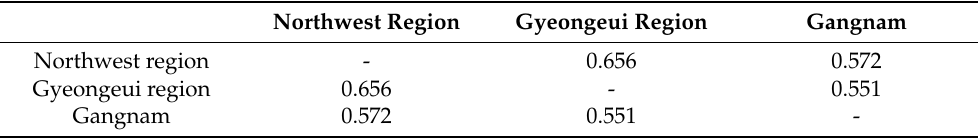
Table 9. Correlation analysis of sales price between